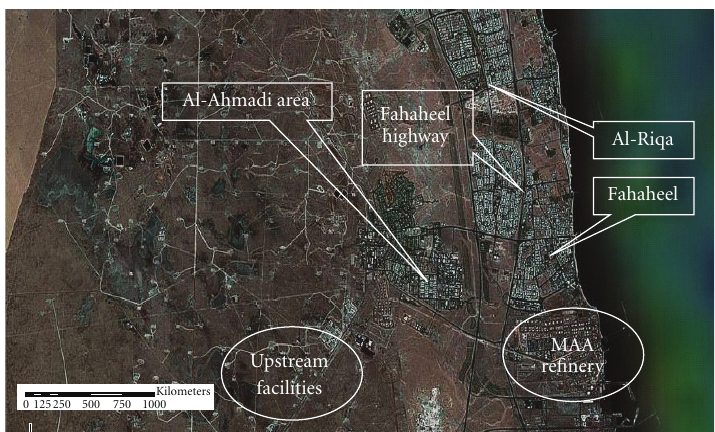
Figure 3: Satellite image showing both areas under investigation (Fahaheel and Al-Riqa) with respect to the main petroleum downstream, namely MAA refinery and upstream facilities in the state of Kuwait. Source: image adapted from KISR satellite archives (Kuwait). Source: Al-Salem and Khan [10].